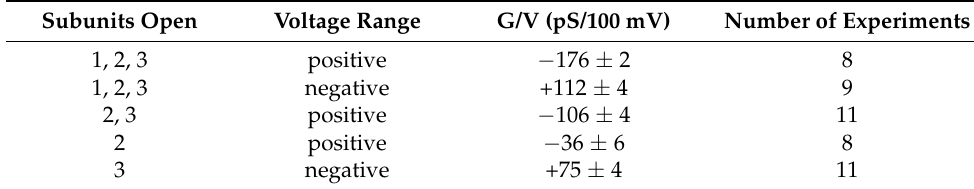
Table 4. Rectification of individual subunits.